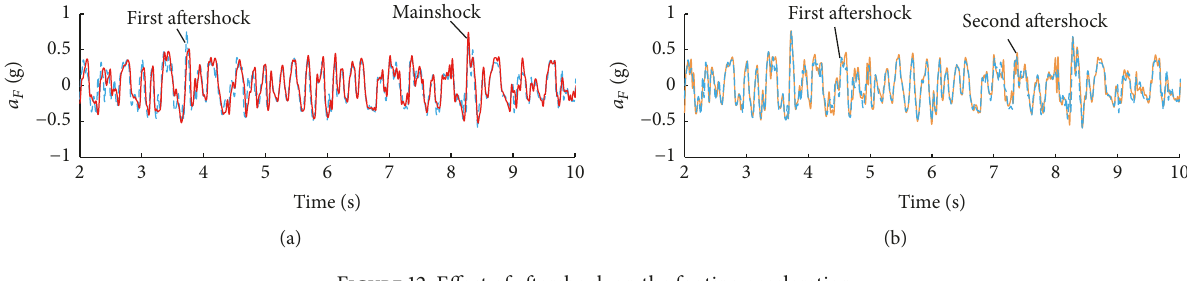
Figure 12: Effect of aftershock on the footing acceleration.